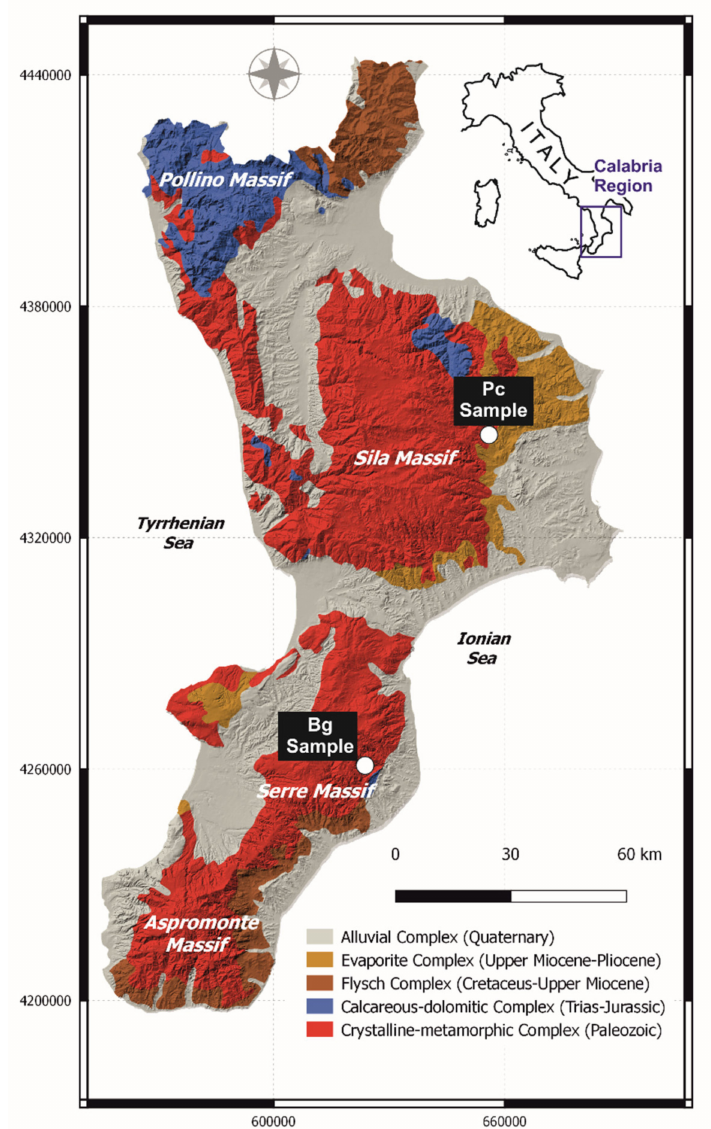
Figure 1. Hydrogeological sketch map of the Calabria region (adapted from [30]) with the locations of Pc and Bg water